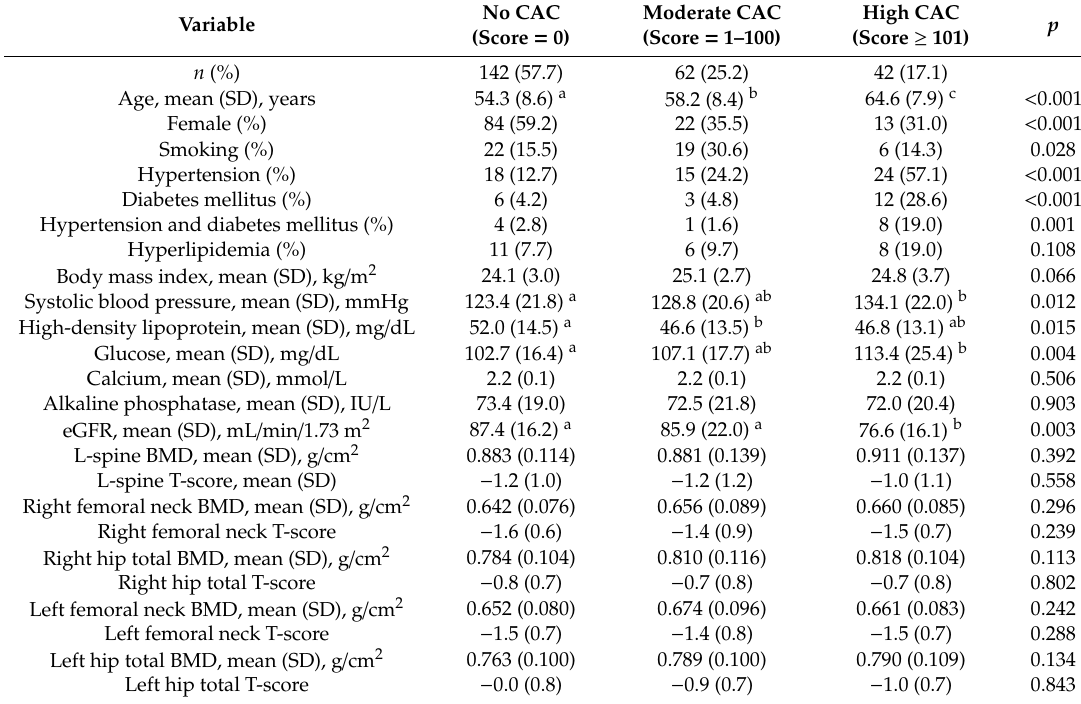
Table 1. Demographic and clinical characteristics of the participants ( n = 246).